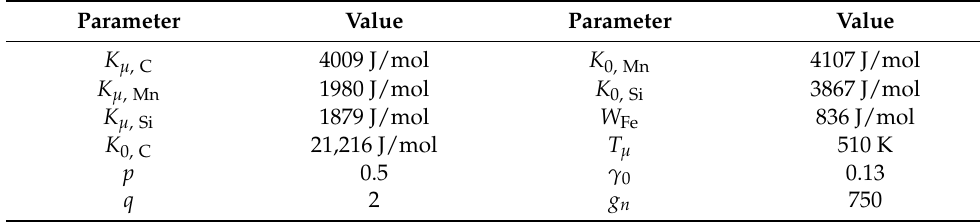
Table 1. Parameter values used to calculate the M σ s temperature. Parameter Value